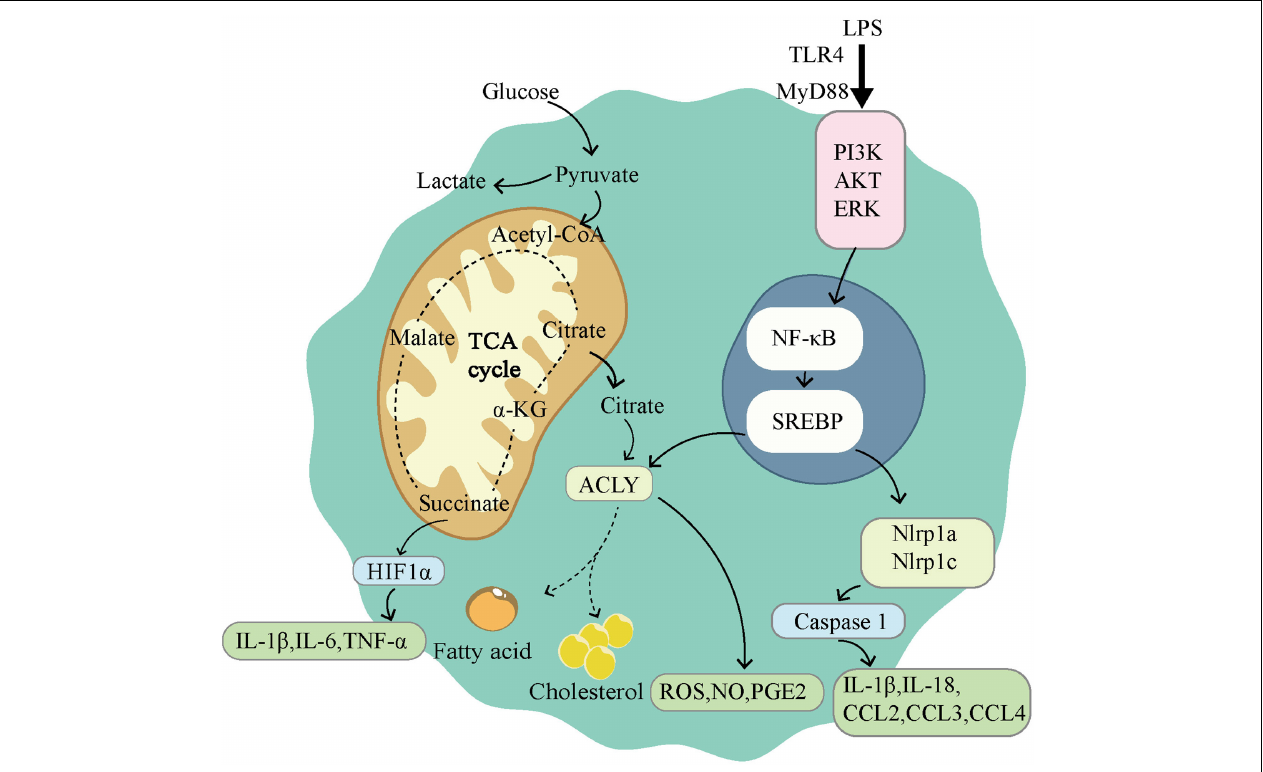
FIGURE 3 | Sterol regulatory element-binding protein (SREBPs) is involved in the activation of M1-type macrophages. M1 macrophages use glycolysis as the main way of energy supply. The tricarboxylic acid cycle is disrupted in M1 macrophages, leading to the accumulation of citrate and succinate. Succinate can activate HIF1 α , which in turn leads to the release of proinflammatory factors. LPS induces the activation of NF- κ B through TLR4 dependent and independent pathways. Activation of NF- κ B induces the expression of SREBPs, promoting lipid synthesis and accumulation. ACLY, as a downstream gene of SREBP, participates in lipid synthesis and drives the release of ROS, NO, PGE2. SREBPs also activate Nlrp1a and Nlrp1c, which lead to the release of proinflammatory